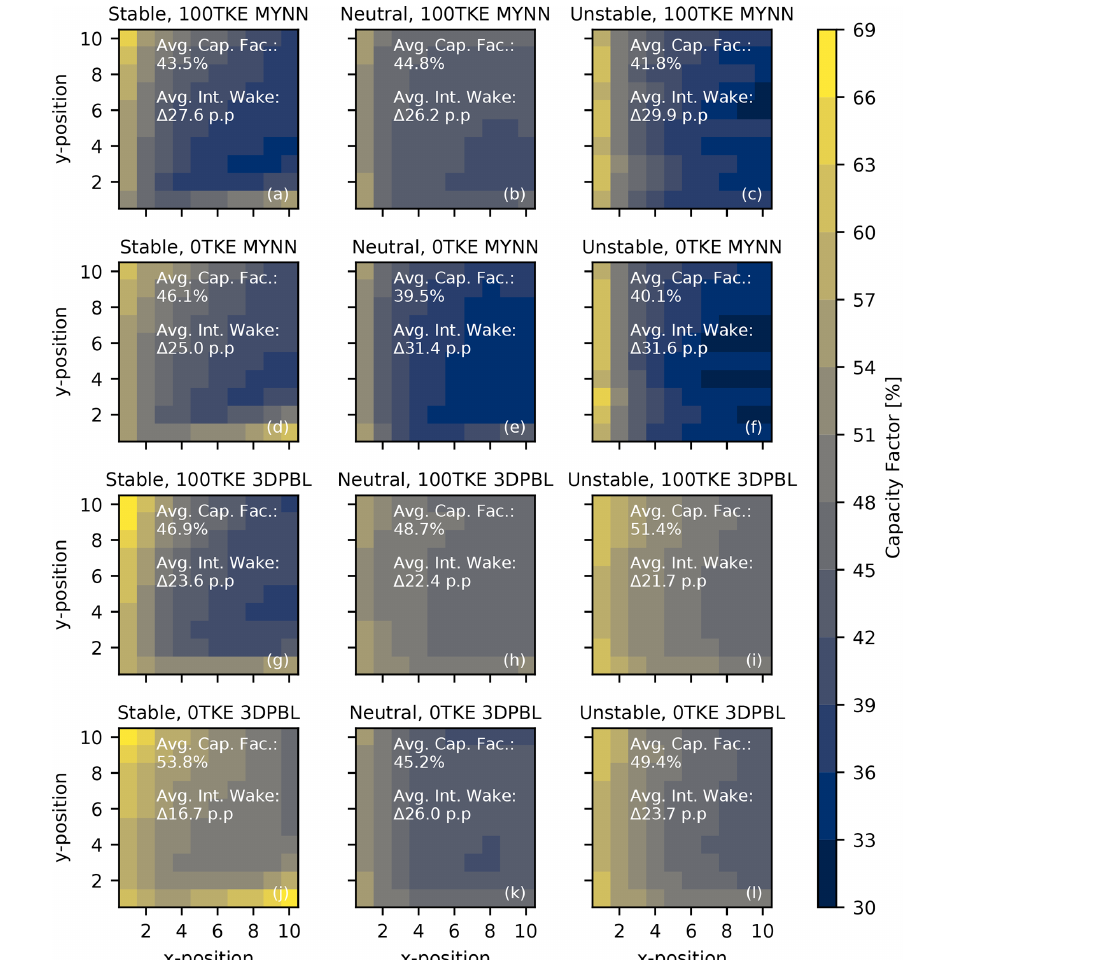
Figure 7. Heat maps of capacity factor for each turbine, based on the turbine’s position in the plant. The average capacity factor and internal wake strength are noted for each